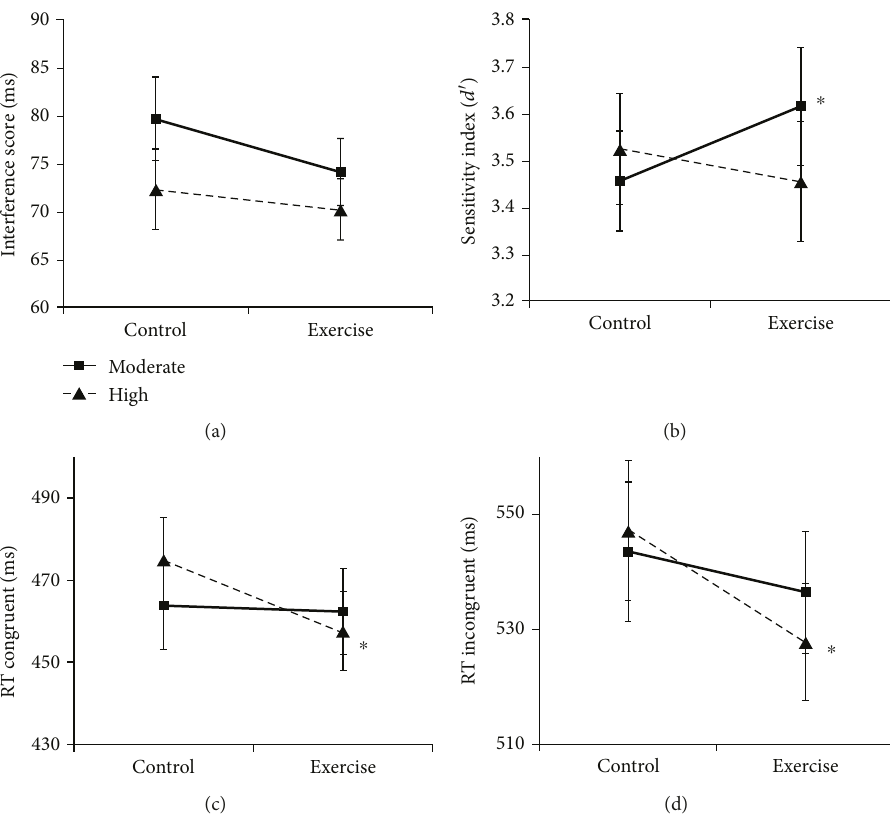
Figure 1: Exercise e ff ects on primary outcome measures of the two executive functioning tasks ((a) fl anker task and (b) Go/No-go task) and measures found to be in fl uenced by high-intensity exercise in an explorative analysis: reaction times in (c) congruent and (d) incongruent trials of the fl anker task. ∗ p < 0 05 (refers to pairwise comparisons, i.e., paired t -tests). (Mean values with standard